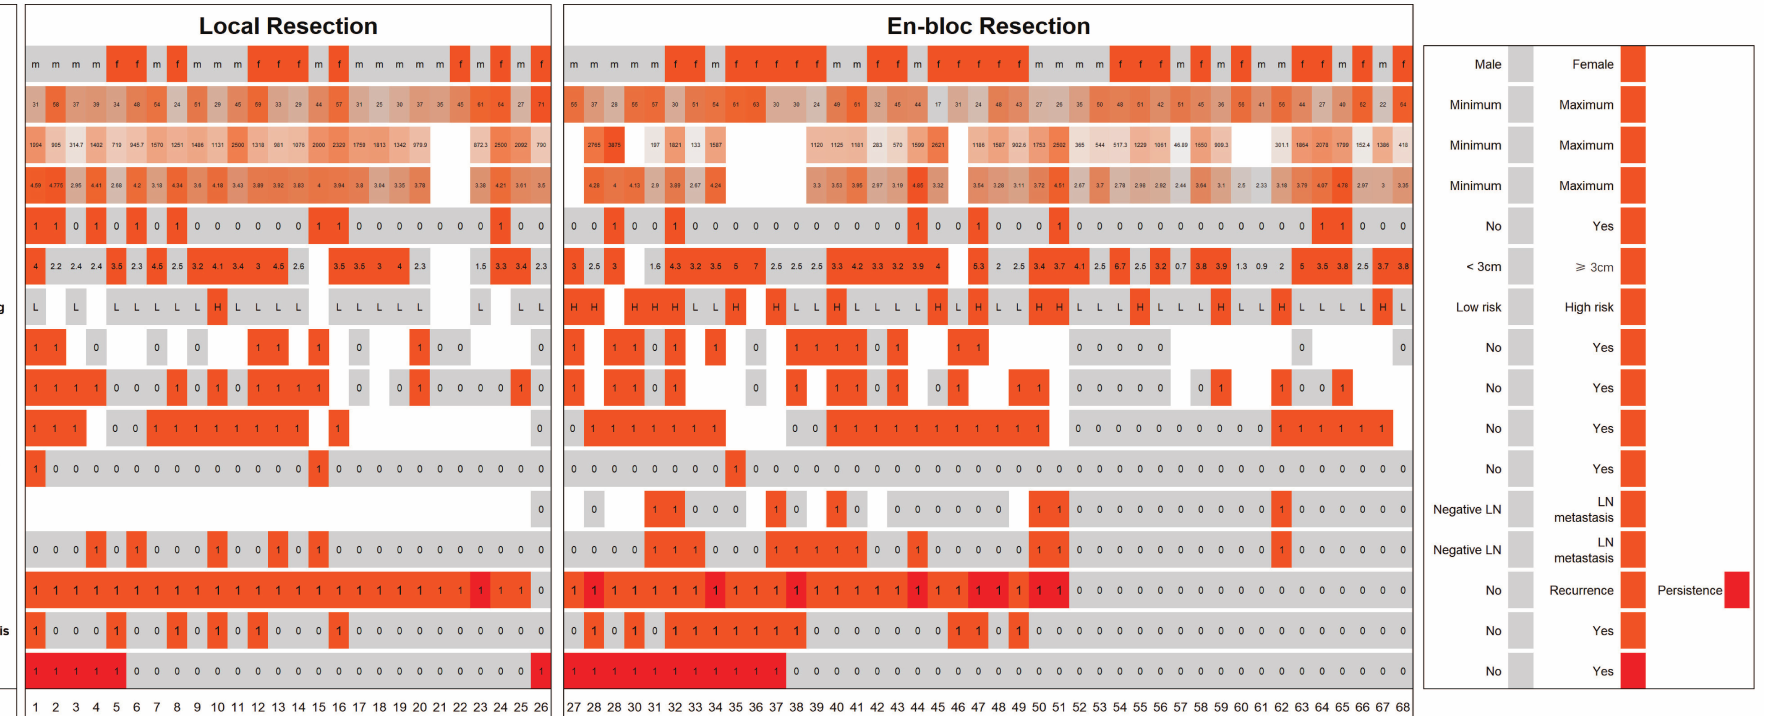
Figure 3. The clinical characteristics, CDC73 abnormalities, Ki67 index, and lymph metastasis status of 68 patients with